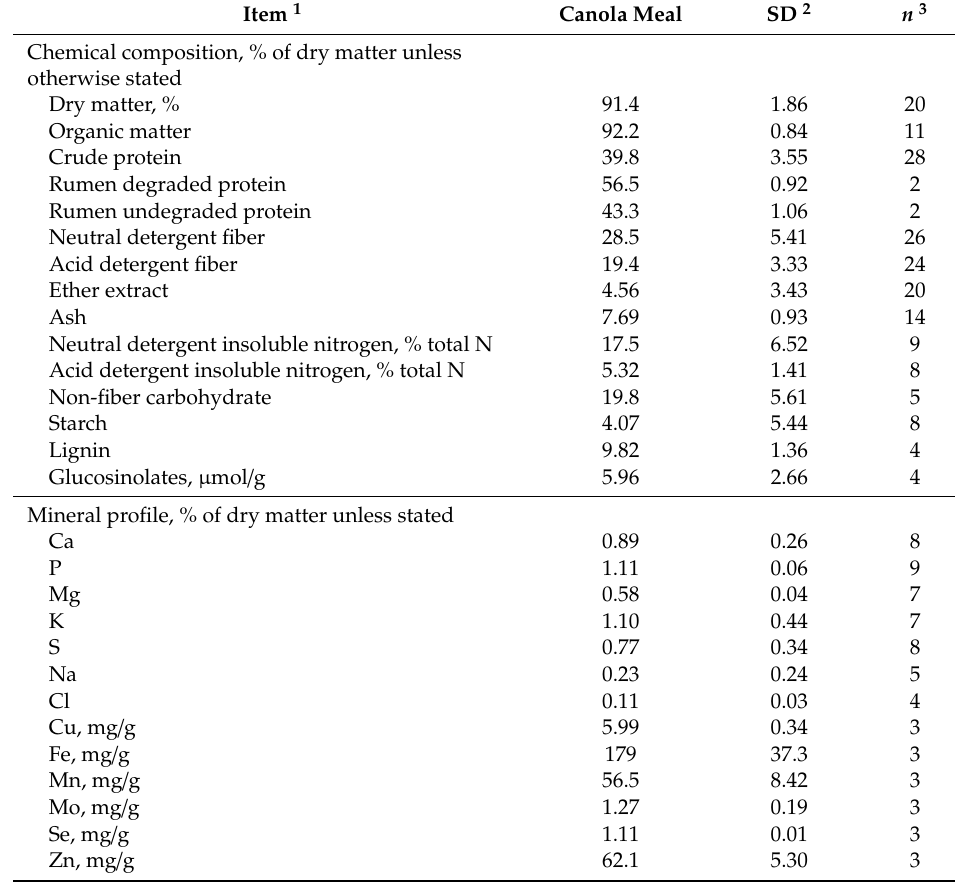
Table 1. Macronutrient chemical composition of canola meal. Item 1 Canola Meal n